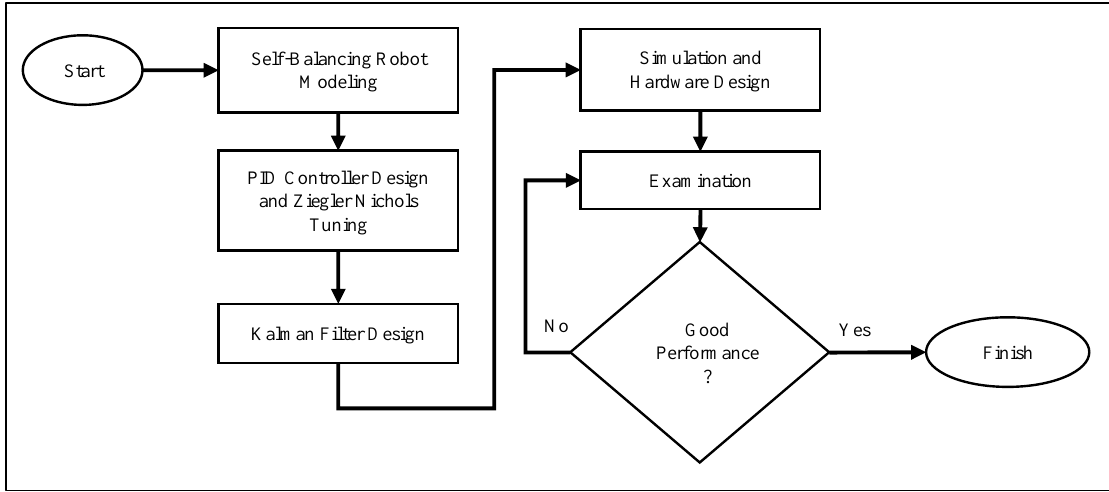
Figure 1. Research